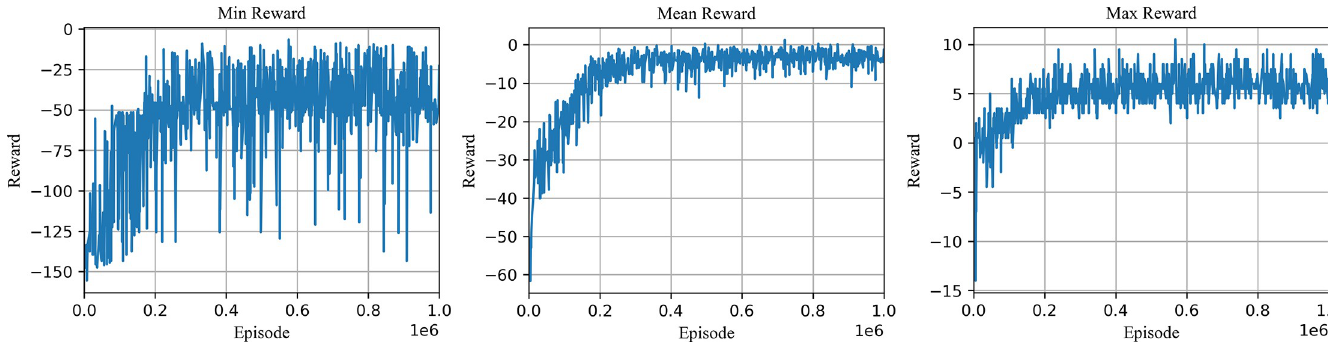
Fig 6. Validation episode rewards for CNN with self-stopping during training. Shown is the (A) minimum, (B) mean, and (C) maximum rewards for the 30 validation episodes performed every 100 training episodes with network parameters held constant.